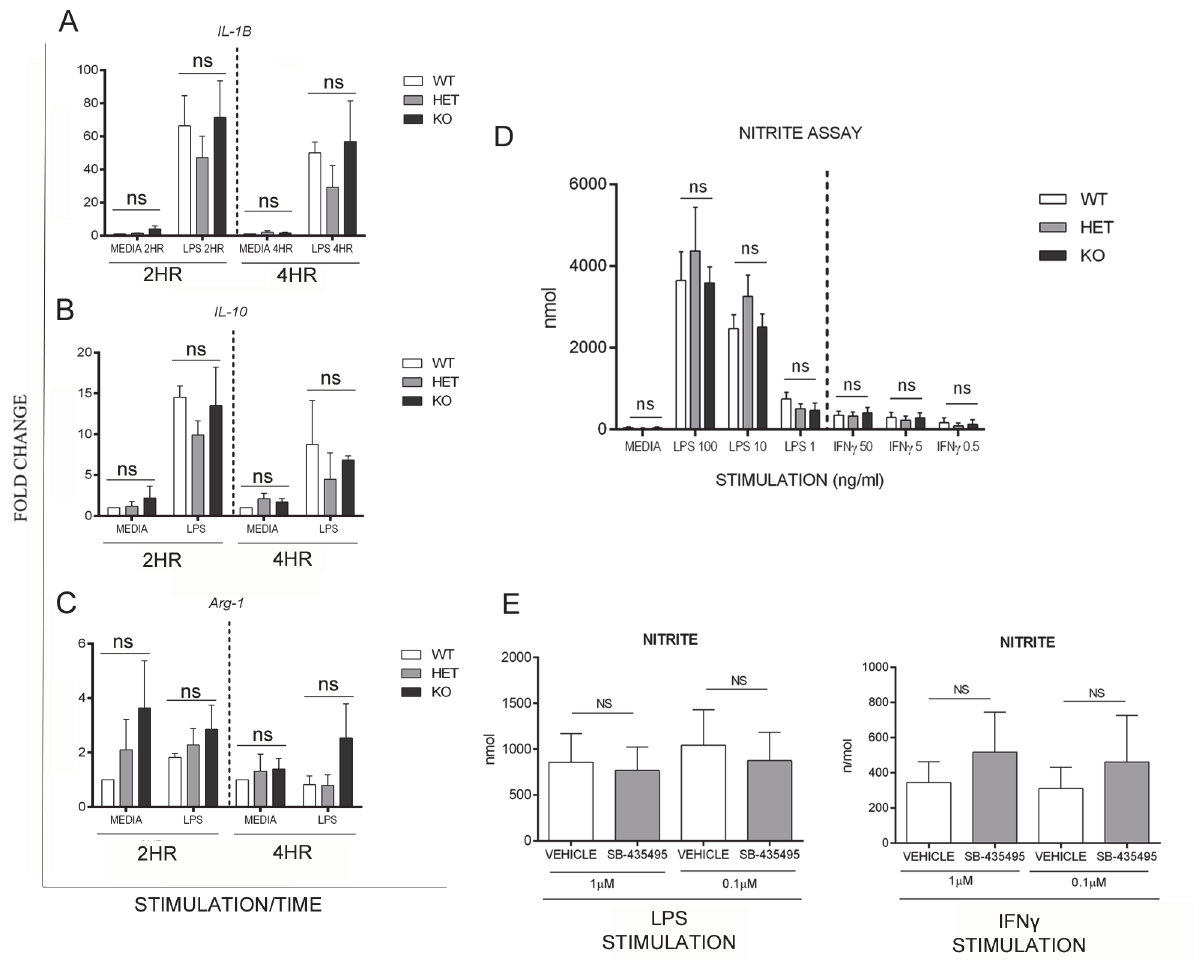
Fig 3. Effect of Lp-PLA2 enzyme ablation on macrophage activation markers as an indicator of macrophage activation status. Expression of IL-1 β , IL-10 and Arginase-1 in Lp-PLA 2 WT, HET and KO mice by RT-qPCR. Data from BMDM, following 2 or 4 hour stimulation with LPS (1ng/ml) or media control A) IL-1 β (n = 3 – 4) B) IL-10(n = 3) C) Arginase-1 (n = 3 – 4). D) A nitrite assay performed as described, using supernatants of BMDM from Lp-PLA 2 WT, HET and KO mice cultured in presence of LPS/IFN γ for 24 hours, showed no significant difference between genotypes (n = 9 from 5 mice). E) Data collected from nitrite assays using supernatants of BMDM treated with either LPS or IFN γ plus SB-435495 (1 μ M or 0.1 μ M) showed no significant difference between genotypes (n = 3) **** p <